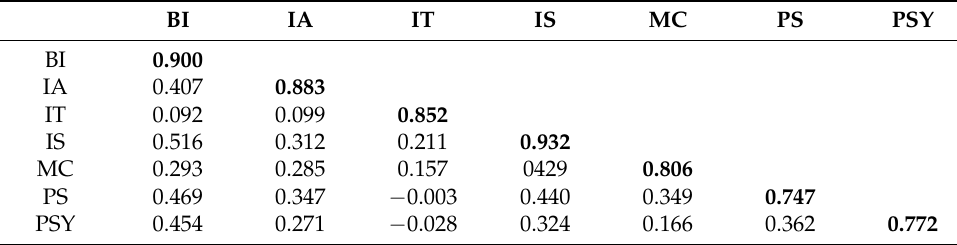
Table 3. Construct correlations and square roots of